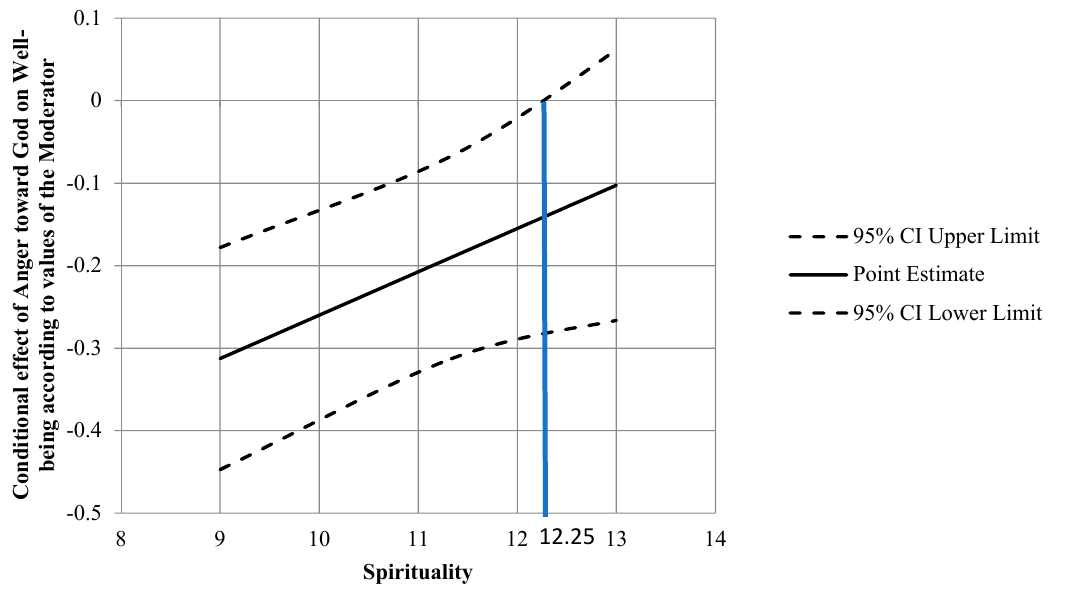
Figure 2. Simple slopes showing the interaction between ATG and spirituality and the effect on well-being.